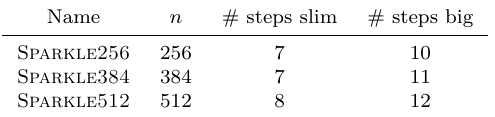
Table 1: The versions of each Sparkle instance.